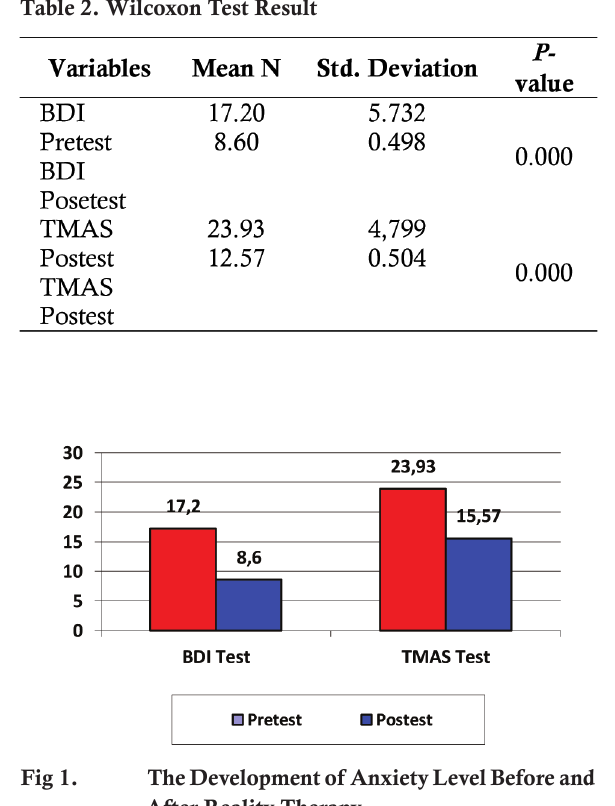
Fig 2. Comparison of Anxiety Levels between Reality Therapy